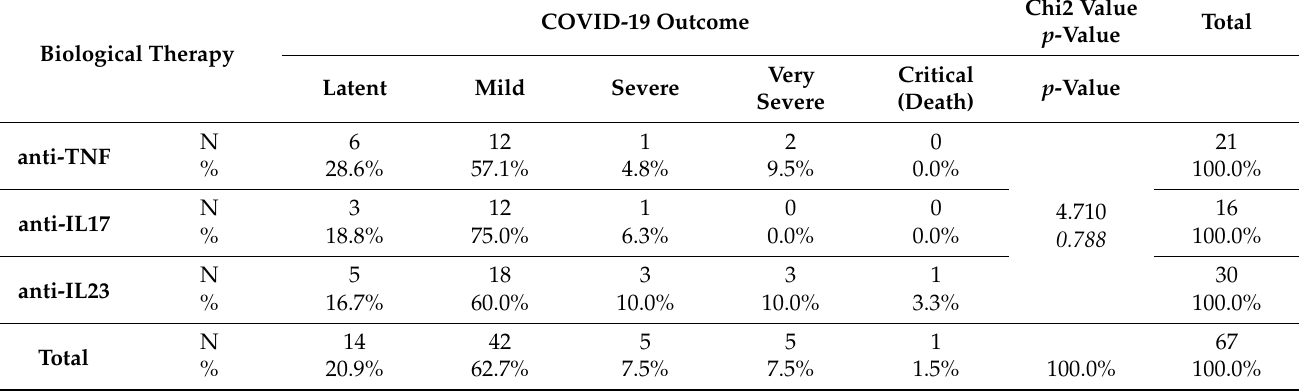
Table 8. Prevalence (numbers and relative prevalence in %) of five levels of COVID-19 outcome severity among psoriatic patients stratified according to three groups of provided biological therapy, differences tested with Pearson’s chi-squared